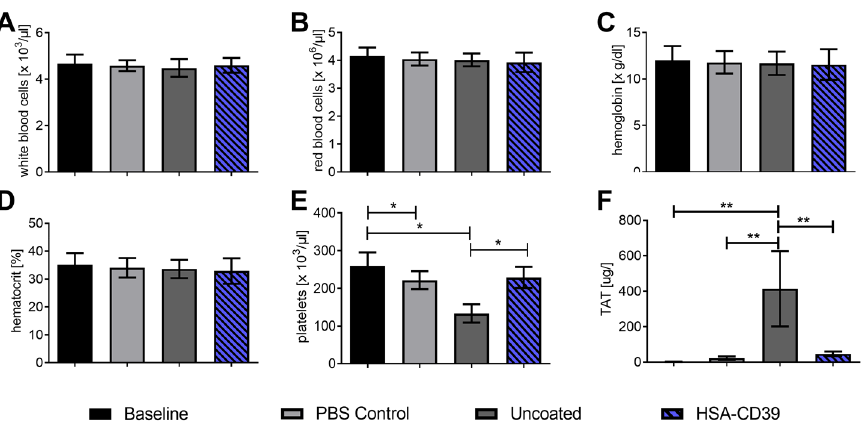
Figure 7. HSA–CD39 coated onto nitinol BlueOxide stents shows no effect on blood haematology or haemocompatibility using a dynamic in vitro thrombogenicity model. Haematology analysis of White blood cells. ( B ) Red blood cells. ( C ) Haemoglobin. ( D ) Haematocrit. ( E ) Platelets. ( F ) TAT ( F ) TAT complex using ELISA measurements. Baseline: directly after venepuncture. Control: tube only. Uncoated: bare nitinol BlueOxide stent. The different groups were compared using repeated- measures ANOVA and Bonferroni post hoc tests (% activated platelets ± SD, * p < 0.05, ** p < 0.01). Values of at least 4 independent experiments are